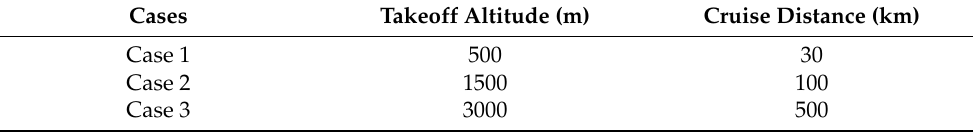
Table 4. Mission profile